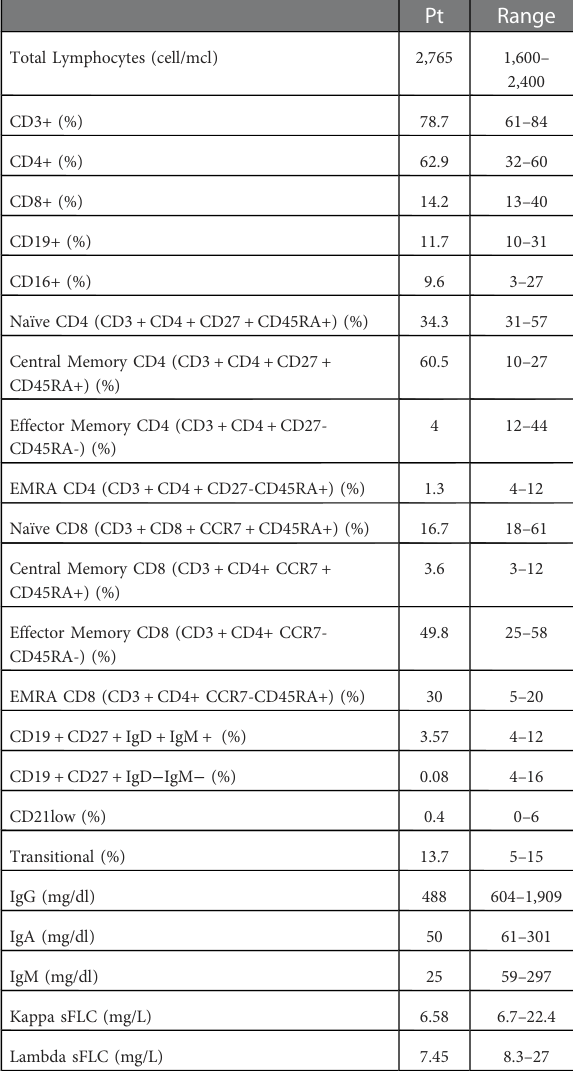
TABLE 1 Immunological